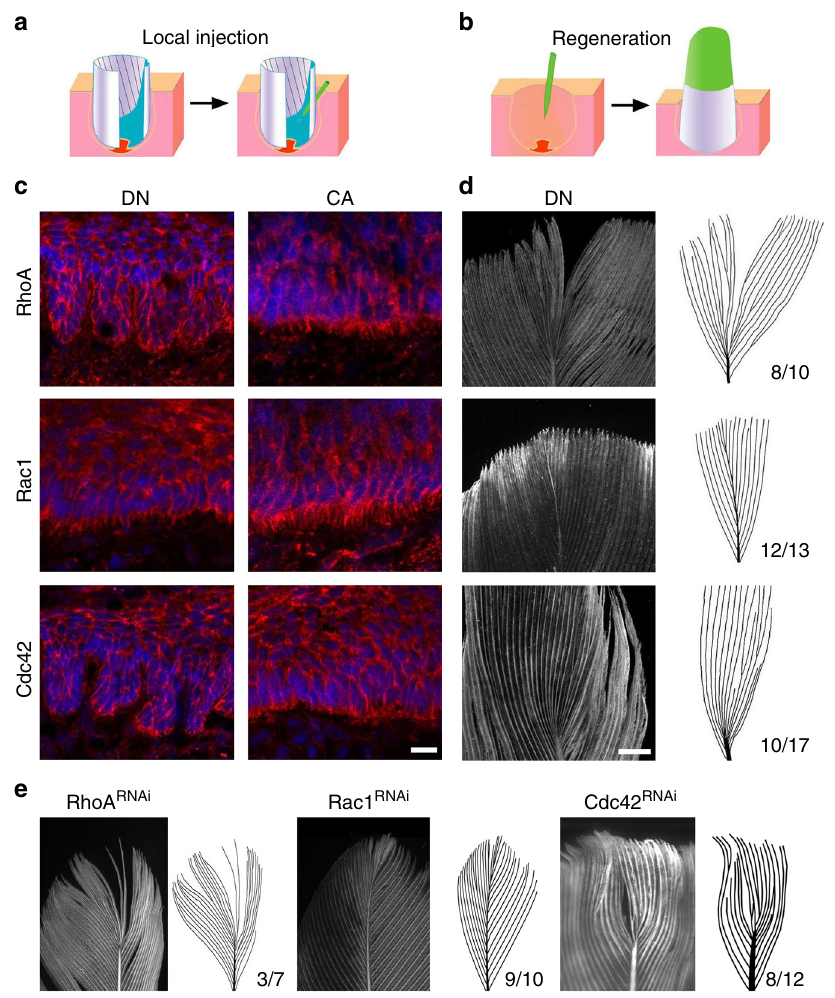
Fig. 3 Filopodia regulate feather branching. a , b Schematics showing two different methods for manipulating gene expression in the feather follicle. Lentivirus were either directly injected into the developing follicle ( a ), or into the follicle cavity after plucking the feather ( b ). c , d The dominant negative (DN) forms of RhoA and Cdc42 , but not Rac1 nor their constitutively active (CA) forms regulated fi lopodia in vivo as shown by β -Catenin staining ( c , local injection in the rachis region) and the fi nal feather form ( d , transgenic feathers). e RNAi knockdown of RhoA or Cdc42 , but not Rac1 disrupted feather axis formation. The numbers indicate the occasions of feathers with the phenotype. Bar = 20 μ m in c , 2 mm in d ,